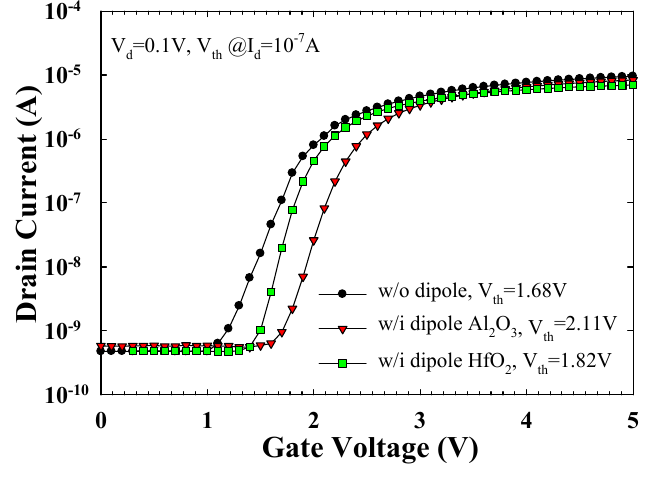
Figure 2. I d –V g curve of the TAHOS NVM devices.